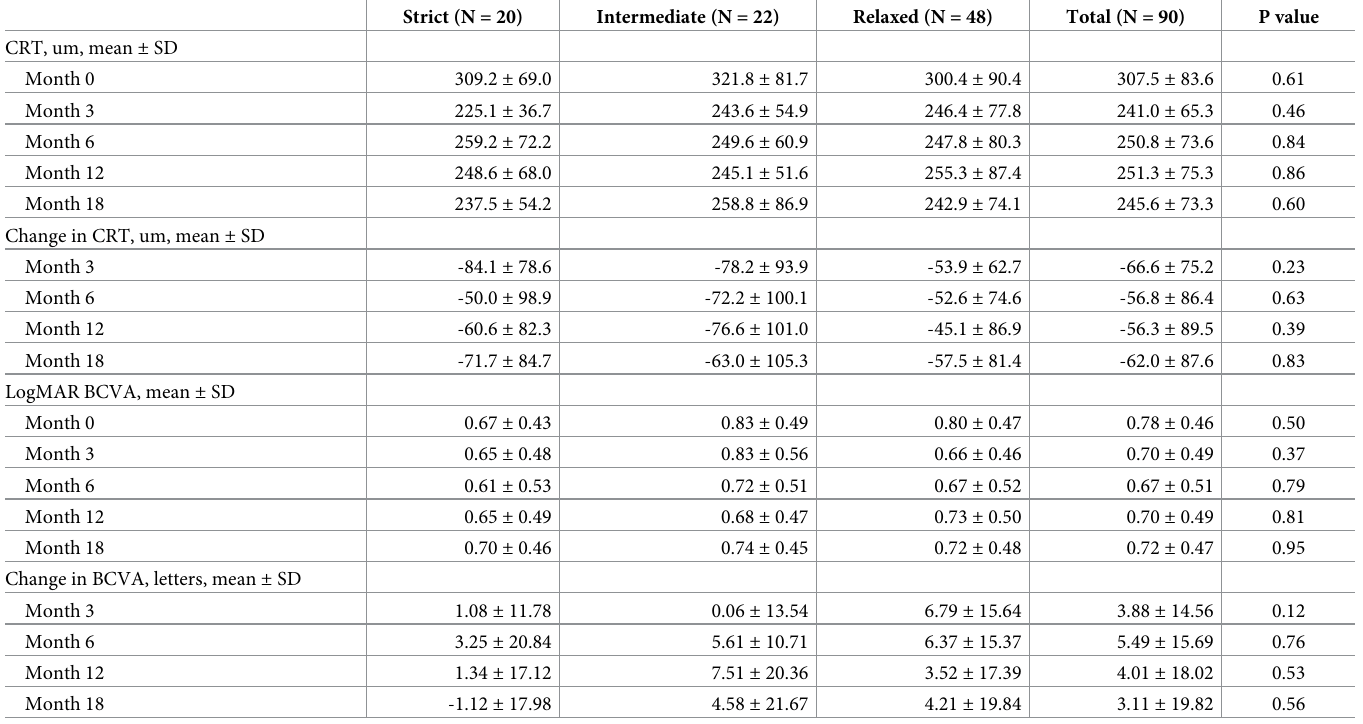
Table 4. Central retinal thickness and best-corrected visual acuity changes among strict, intermediate, and relaxed